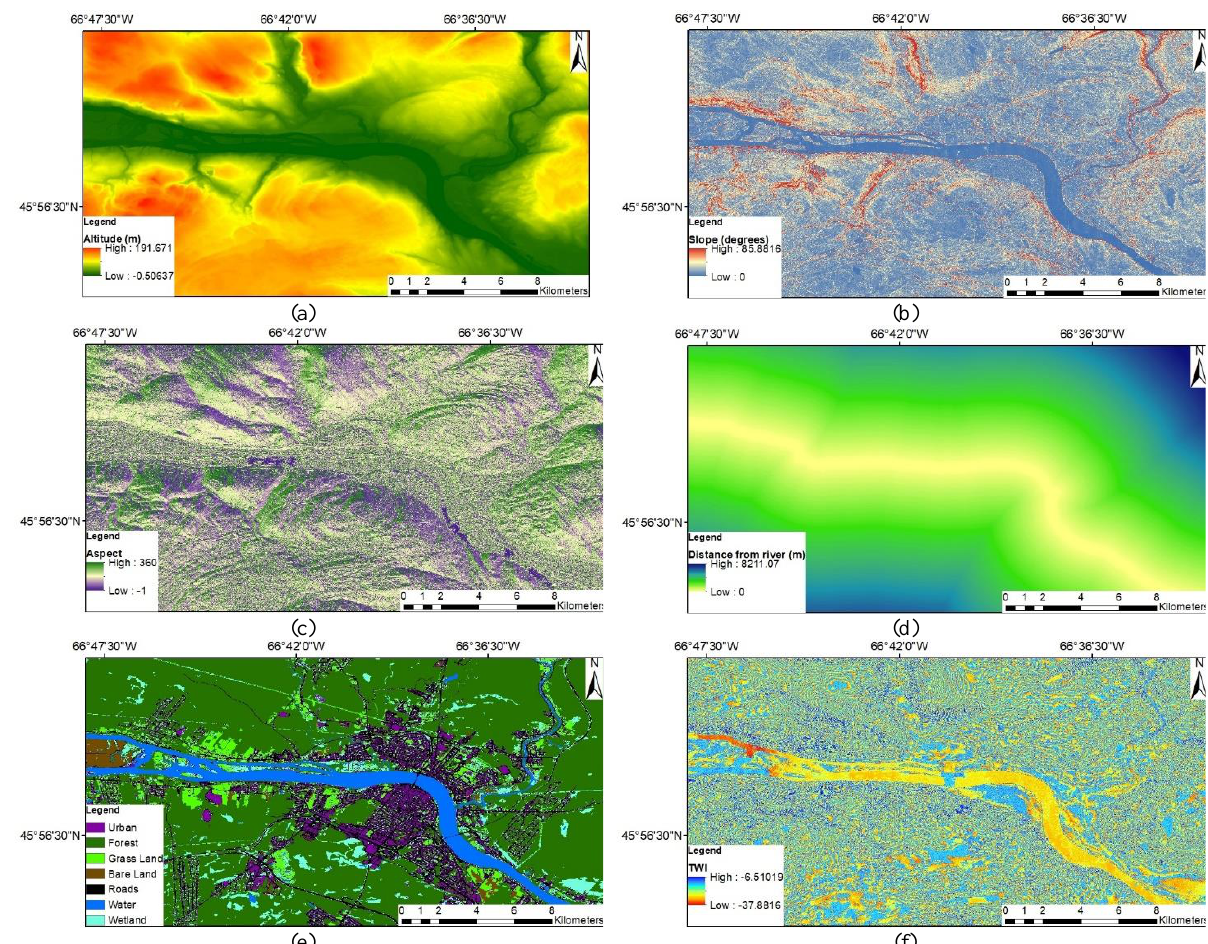
Figure 3. Conditioning factors used in the Random Forest classifier (part 1): (a) Altitude (b) Slope (c) Aspect (d) Distance from river (e) Land-use/cover (f) TWI